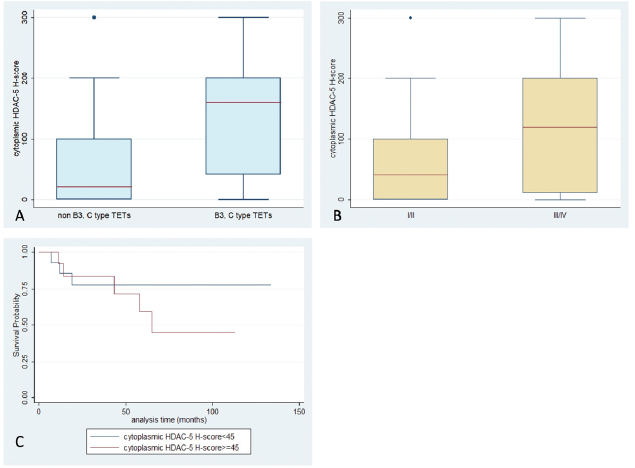
Figure 6. Schematic representation of the associations between cytoplasmic HDAC5 H-score and ( A ) WHO histological type, ( B ) Masaoka–Koga stage, and ( C ) patients’ overall survival. 2.6. Expression of HDAC6 in TETs and Associations with Clinicopathological Characteristics HDAC6 immunoreactivity was observed in 29.6% of the examined cases, and was predominantly cytoplasmic (Table 2, Figure 1). Epithelial rich TETs (namely B3-type and thymic carcinomas) displayed more frequent positivity (Fisher’s exact test, p = 0.017, 48% vs. 18%, Figure 7A) and higher H-scores compared to the rest of the histological types (Mann–Whitney, p = 0.008, median value 30 vs. 0). Moreover, a higher cytoplasmic HDAC6 H-score was encountered in tumors with an advanced Masaoka–Koga stage (IVa or IVb) (Mann–Whitney, p = 0.008, median value 70 vs. 0, Figure 7B). There was not any significant correlation with the presence of relapse or patients’ OS or with any of the re- maining clinicopathological parameters. No expression was observed in the lymphocytic component. Figure 7. Schematic representation of the associations between cytoplasmic HDAC6 H-score and ( A ) WHO histological type, ( B ) Masaoka–Koga stage, and ( C ) patients’ overall survival.